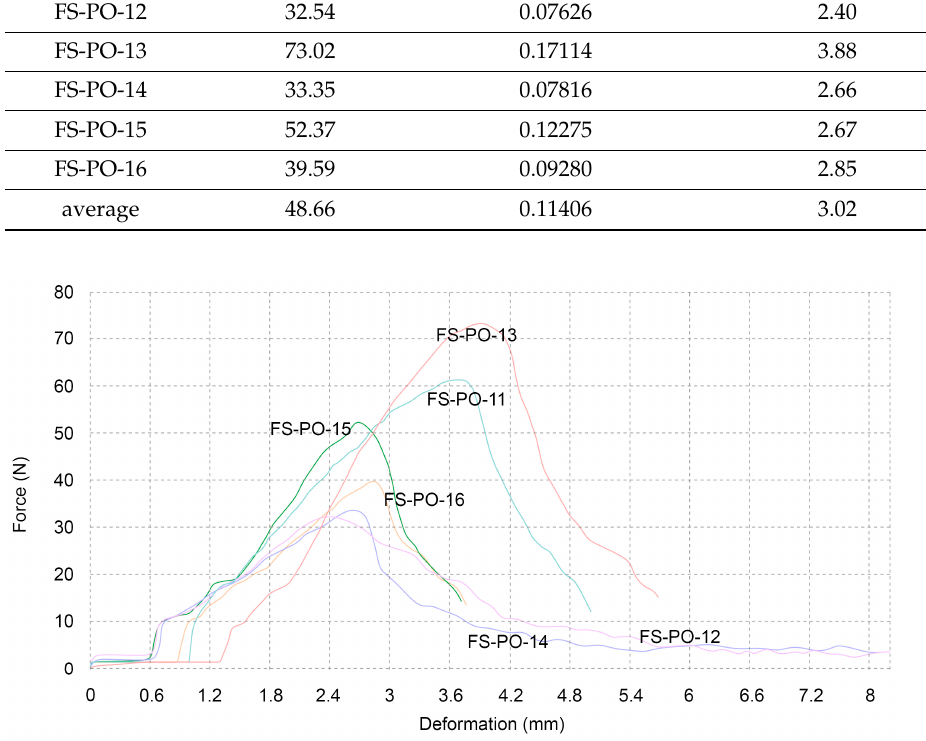
Figure 8. Three point flexural test of beech sawdust samples.